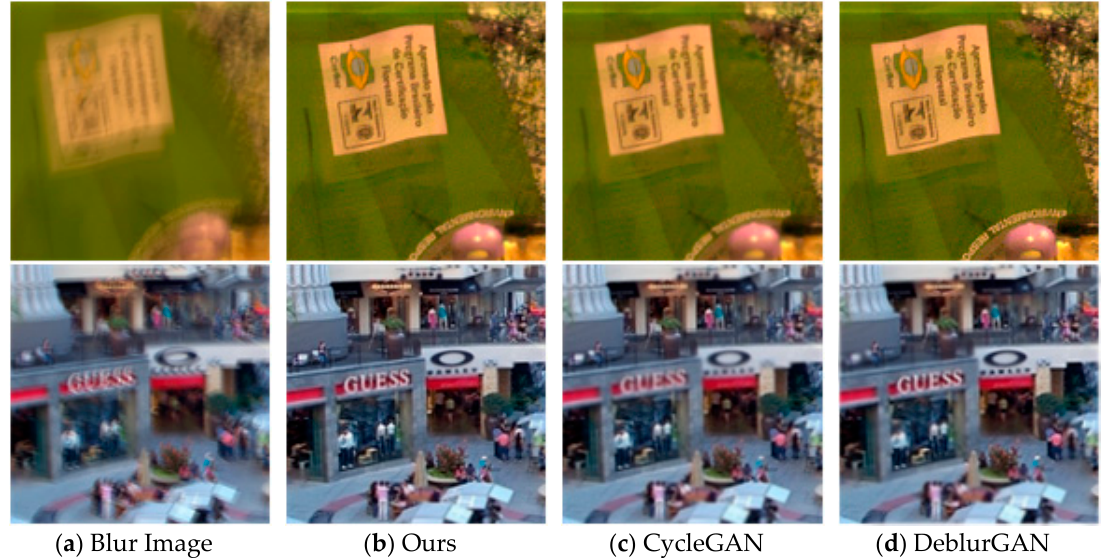
Figure 9. Experimental results of different algorithms on GOPRO dataset.